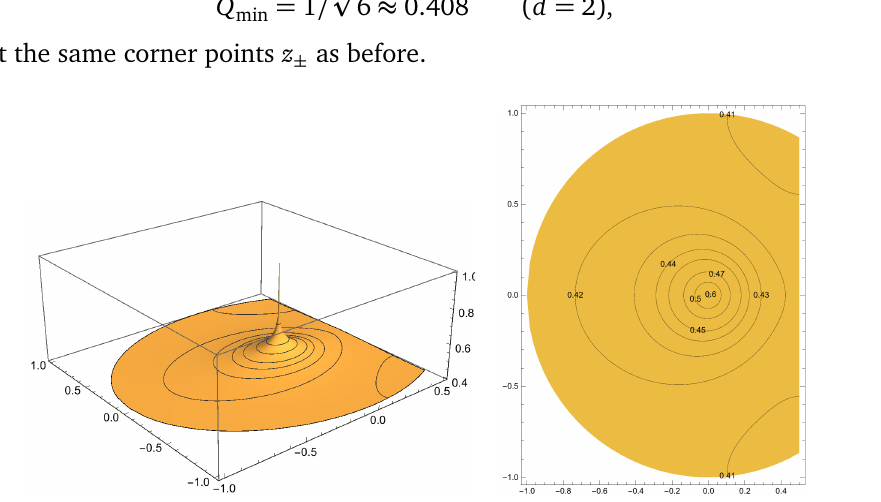
Figure 2: Q in critical 2d Ising, plotted in region R